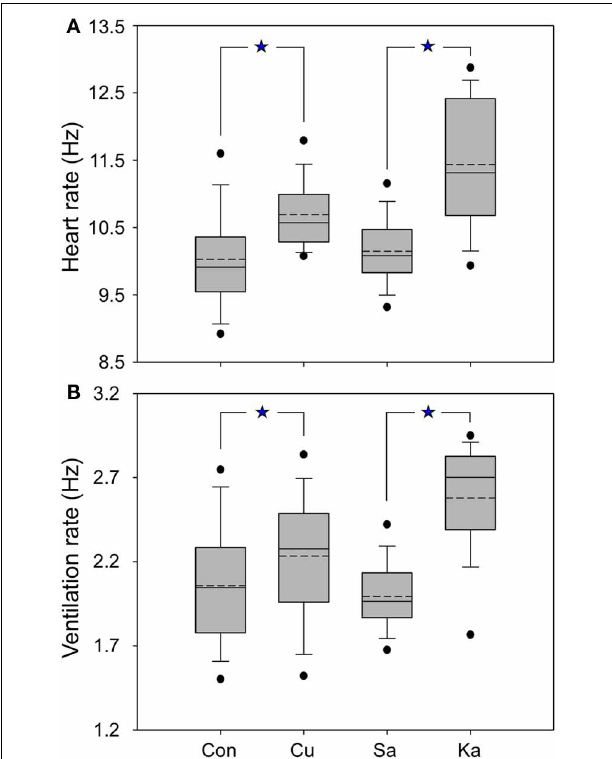
FIGURE 2 | Box plots showing the averaged heart rate (A) and respiration (B) of mustached bats for control and experimental conditions. Control (Con) refers to the data collected before performing current (Cu) and KA stimulation; saline (Sa) means the data were collected after saline injection at the same site as electrical and KA stimulation. Dashed lines are means, solid lines are medians; boxes surround 1 SD , whiskers are 10th and 90th percentiles, and black dots are 5th and 95th percentiles. All data are normalized relative to the pre-stimulation HR and VR (see Materials and Methods). ∗ p < 0 .